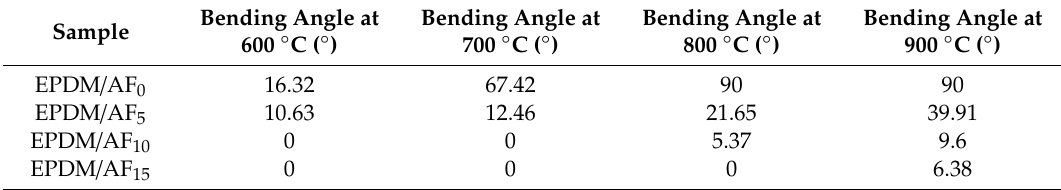
Table 7. Bending angles for the residues of ceramifiable EPDM composites firing at different temperatures. Sample